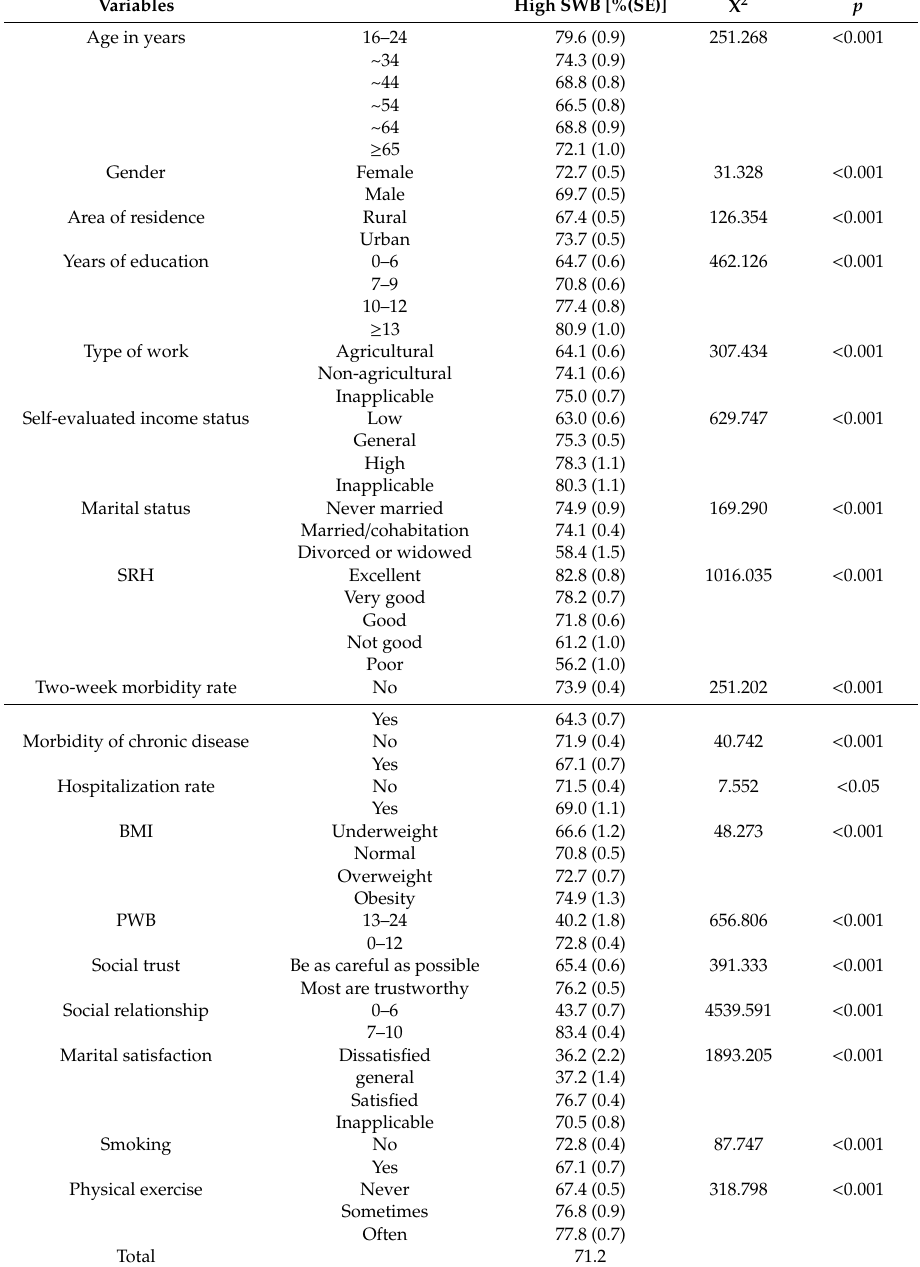
Table 2. The distribution of high subjective well-being (SWB) and univariable